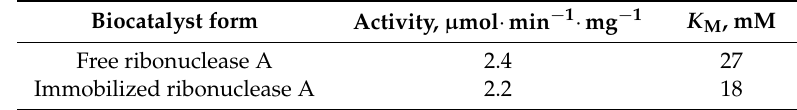
Table 3. Kinetic parameters of cytidine-2’,3’-cyclophosphate hydrolysis catalyzed by ribonuclease.